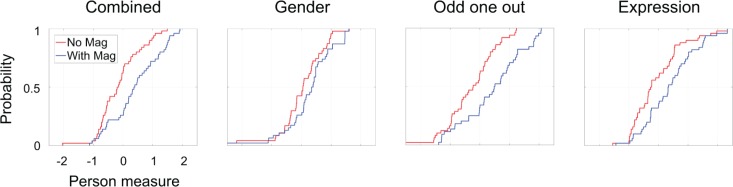
Cumulative distribution functions of person measures.Cumulative distribution functions of estimated person measures are shown for the "without magnification" condition (red) and for the "with magnification" condition (blue). Magnification improved performance in all tasks, with the average increase in person measure being Δθ = 0.552 (p<10−7 using a paired t-test) across all tasks, Δθ = 0.226 (p<0.035) for the gender identification task, Δθ = 0.727 (p<10−7) for the odd one out task, and Δθ = 0.452 (p<10−4) for the emotional expression identification task.